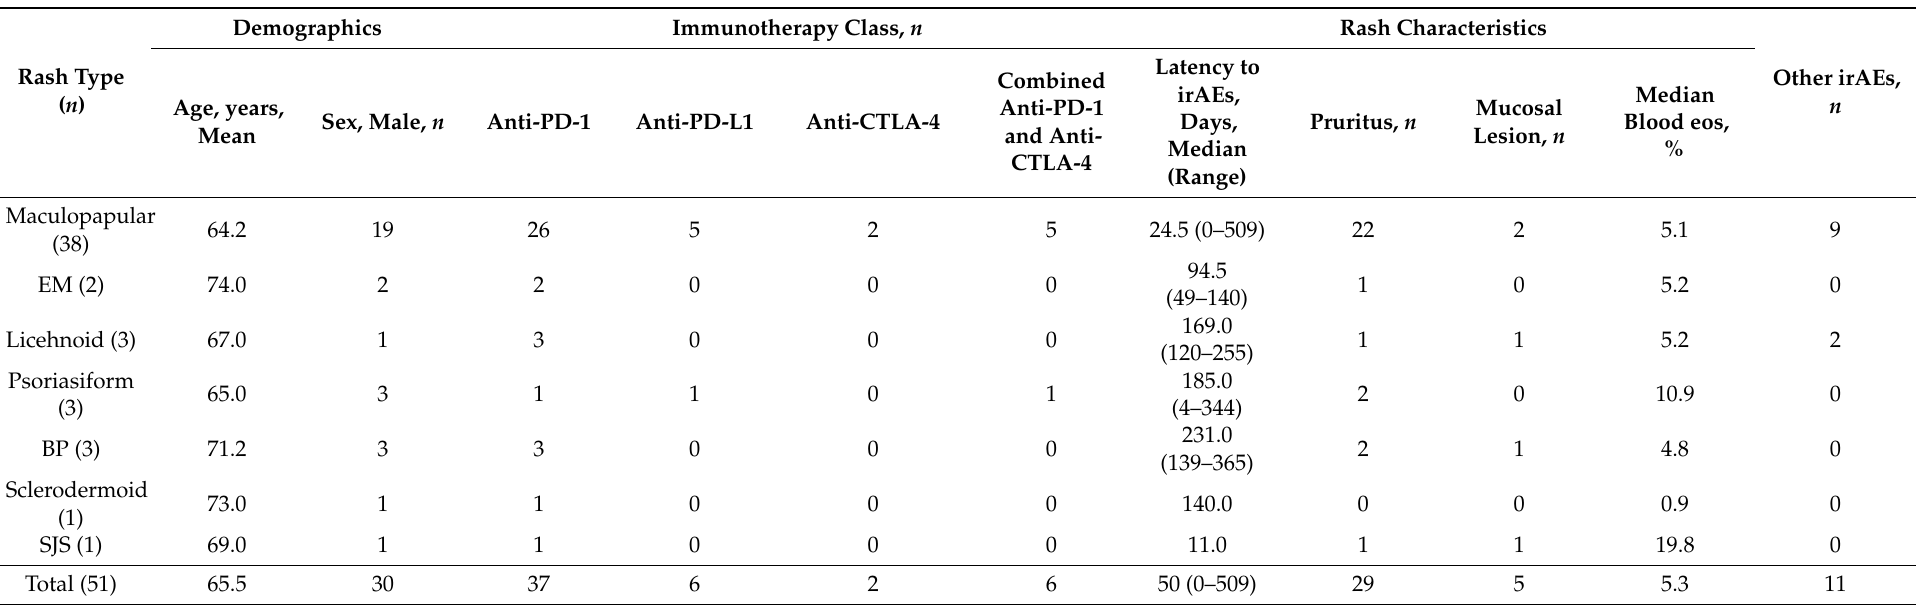
Table 3. Summary of patient demographics, associated immunotherapy class, rash characteristics, and other